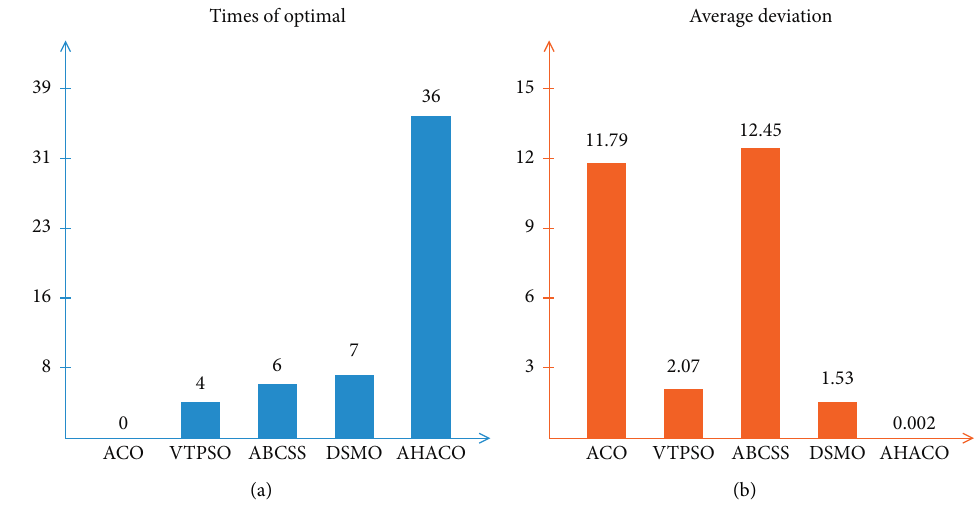
Figure 6: Performance comparison. (a) Times of optimal obtained. (b) Average deviation of solutions. Table 2: Comparison with MO-GA.